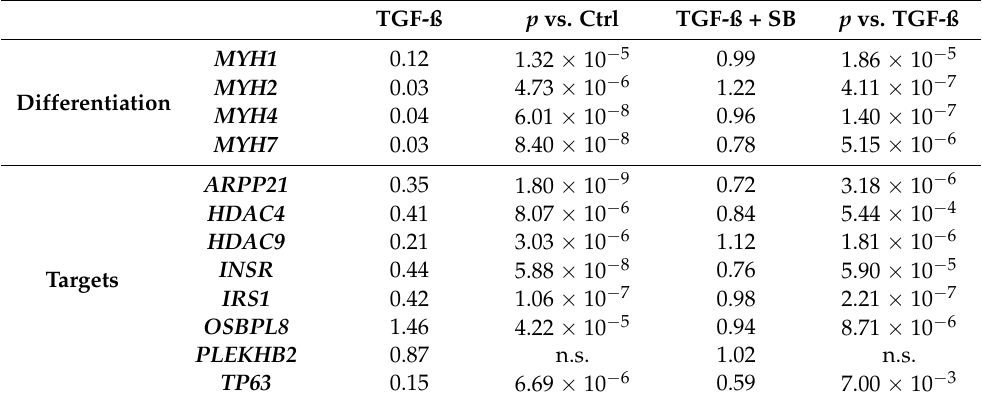
Table 2. Regulation of potential miR-143/145 cluster targets by TGF- β 1 in differentiated skeletal muscle cells.